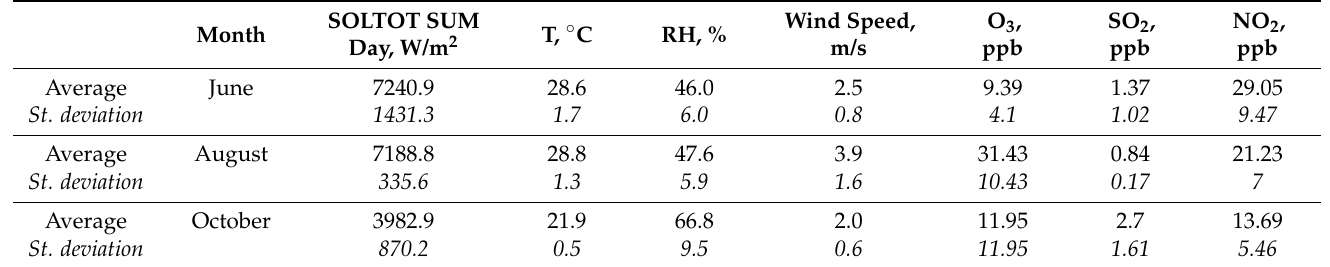
Table 1. Weather conditions and air pollutant levels during the sampling days of the three campaigns in Athens,